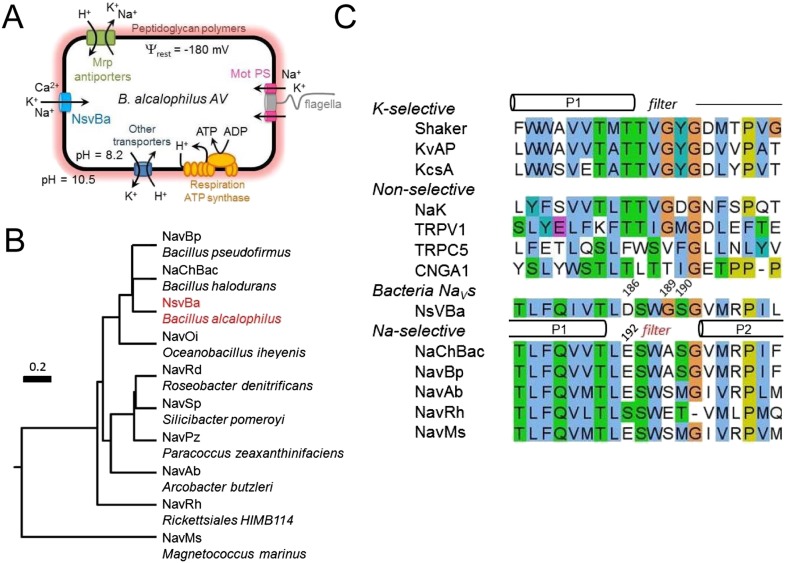
The alkaliphilic Bacillus cation cycle and the relationship between bacteria Nav homologs.(A) A diagram depicting the membrane proteins involved in the Na+ cycle of Bacillus alcalophilus. The cation/proton antiporters, including Mrp antiporters, catalyze net proton accumulation in the cytoplasm in cells that are extruding protons during respiration. Na+ re-entry in support of pH homeostasis is achieved by Na+ solute symporters and through the voltage-gated channel, NsvBa . (B) Relatedness within functionally characterized members of the bacterial sodium channel superfamily. A rooted phylogenic tree analysis of bacterial Nav channels calculated by using the CLUSTALW program (http://clustalw.genome.jp). Branch lengths are proportional to the sequence divergence (scale bar = 0.2 substitutions per amino acid site). (C) An alignment of the selectivity filters from various Na+, K+, and nonselective ion channels. The pore region from the indicated ion channel families (italic) were aligned using the ClustalW multiple sequence alignment program applying the default color scheme with <60% conservation of character: Hydrophobic (blue); polar (green); glutamine, glutamate, aspartate (magenta). Special amino acids are designated with their own color: glycine (orange); proline (yellow) and tyrosine or histidine (cyan). The barrels indicate the regions spanning the pore helices found in the Shaker (K+-selective), NaK and NavRh crystal structures.